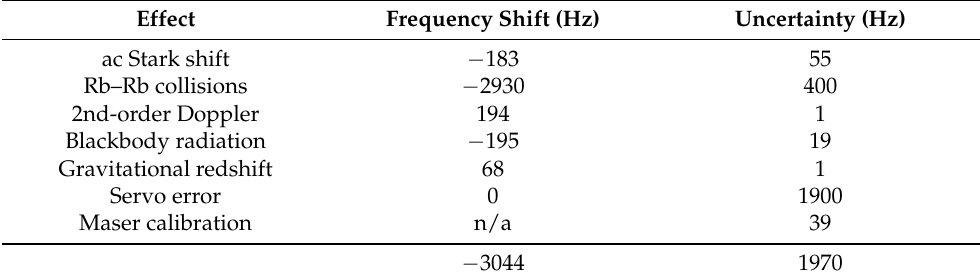
Table 1. Summary of the frequency shifts that were corrected, and their associated uncertainties.